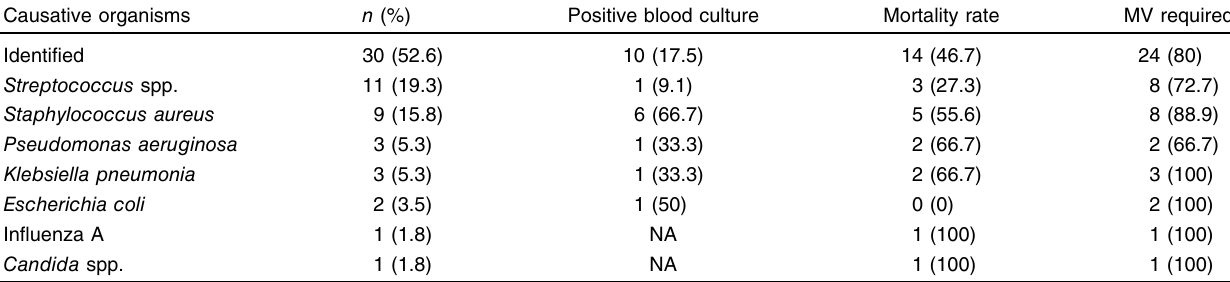
Table 6 Microorganisms isolated from the clinical culture